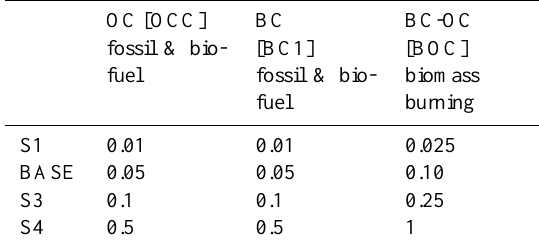
Table 2. Emission sizes, geometric mean mass diameters in [ µ m] of carbonaceous